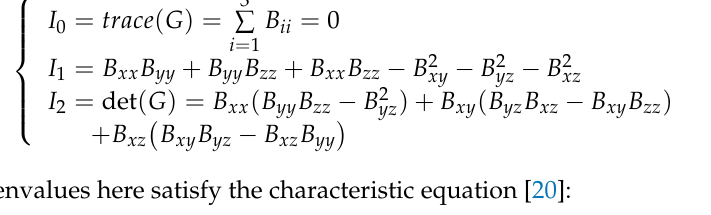
 ≥  ≥  , v , v are the correspond- v , 1 2 3 2 3 1